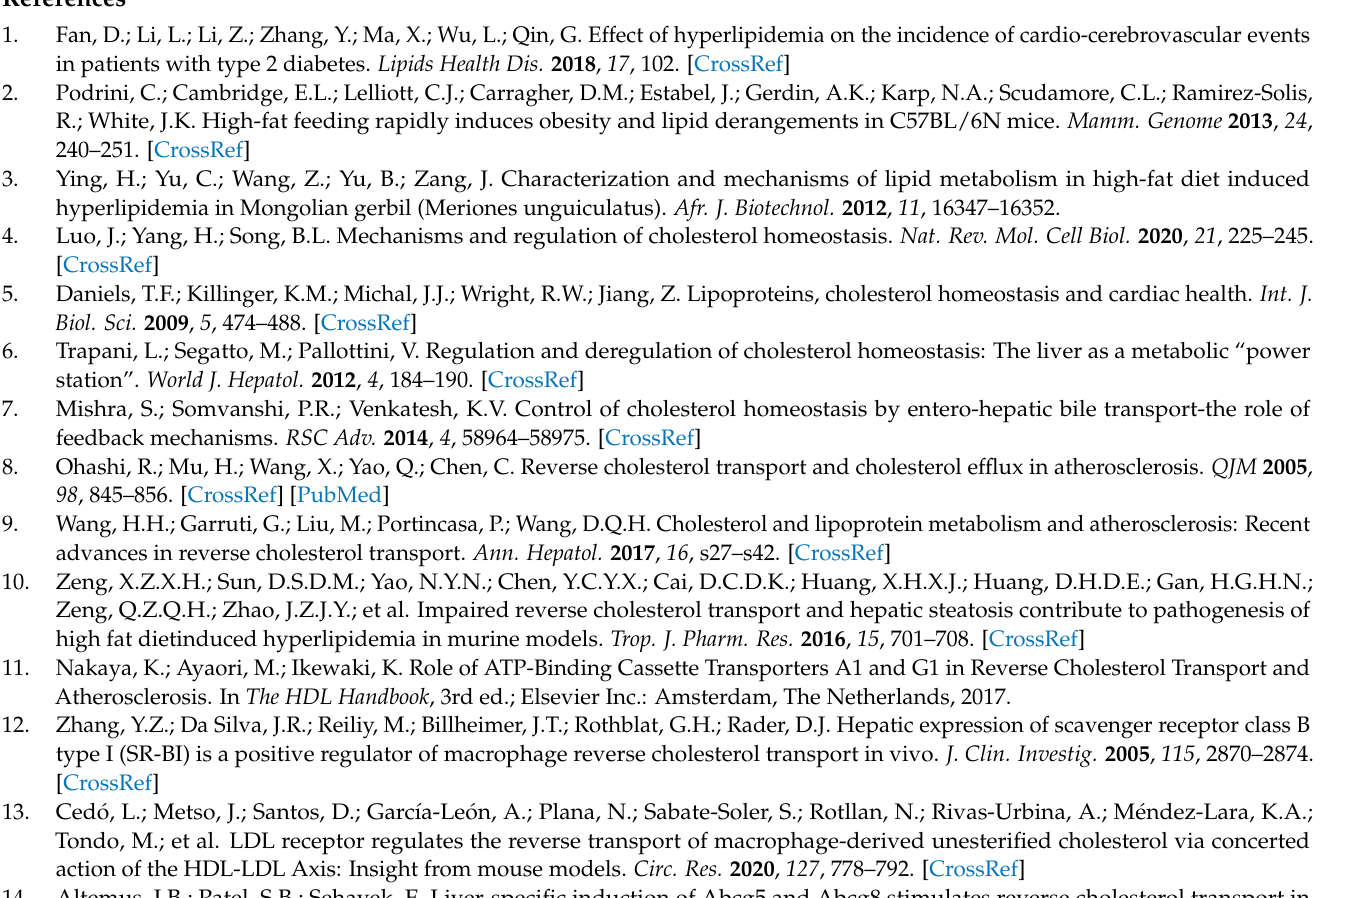
Figure 4D, Table S10: Summary of relative protein levels for Figure 4D, Table S11: Intensity ratios of Western blots for Figure 4F. Table S12: Summary of relative protein levels for Figure 4F, Table S13: Intensity ratios of Western blots for Figure 5B, Table S14: Summary of relative protein levels for Figure 5B, Table S15: Intensity ratios of Western blots for Figure 5D. Table S16: Summary of relative protein levels for Figure